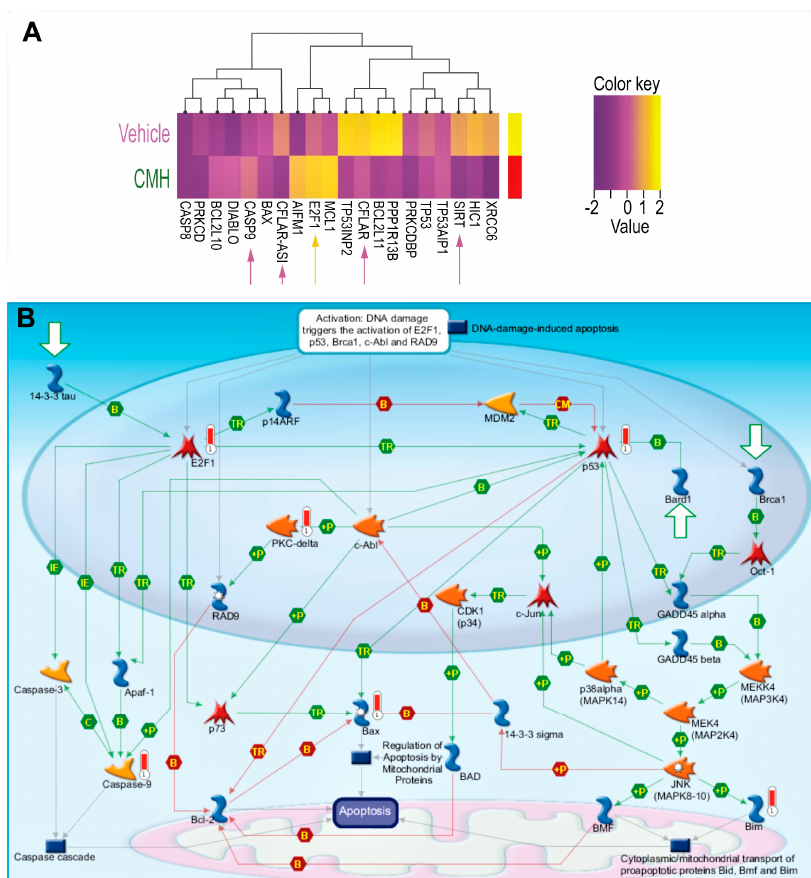
Figure 2. CMH decreases SIRT1-mediated survival signaling in IPF-lung myofibroblasts. RNA-seq and specific gene changes of CMH (30 µM) and fold ratio to vehicle (4% DMSO) in the IPF-lung myofibroblast CCL-191 cell line. ( A ) Heat map. K-means hierarchical clustering (K = 10) of 10,000 genes. Yellow indicates high-level expression and red-purple indicates low-level expression (Z score range − 2 to +2). Both plots show two distinct clusters with significant signatures, including overexpressed genes belonging to different survival pathways ( p = 0.0021, adjusted p <0.0325; p = 0.0045, adjusted p < 0.0156). ( B ) MetaCore maps’ signaling pathways explored using the systems